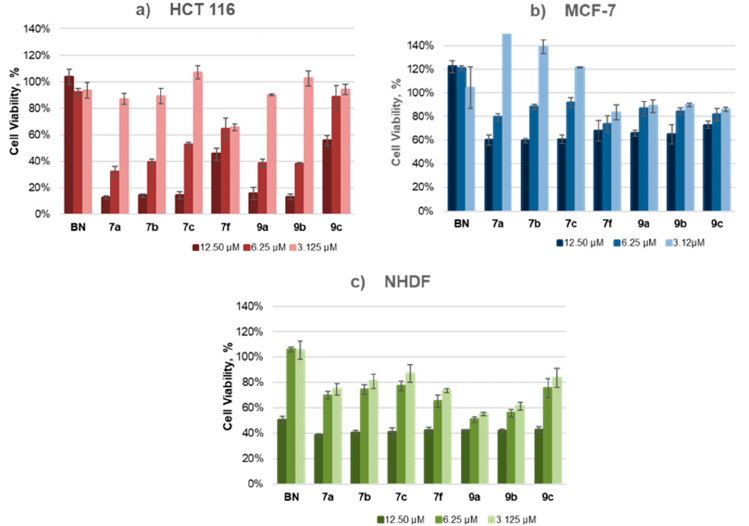
Figure 5. The dependence of cell viability on the concentration of BN and 28-TPP ⊕ BN ( 7 ) and the 3,28- bis TPP ⊕ BN analog ( 9 ) after 24 h of incubation. As expected, triphenylphosphonium derivatives of BN showed greater cytotoxicity than the parent BN toward all of the cell lines tested. The level of inhibition of cell viability depended on the concentration of the tested substances and cell type. The tested analogs of BN had the greatest effect on the viability of the HCT 116 cells (Figure 5a) and the lowest on the viability of the MCF-7 cells (Figure 5b).